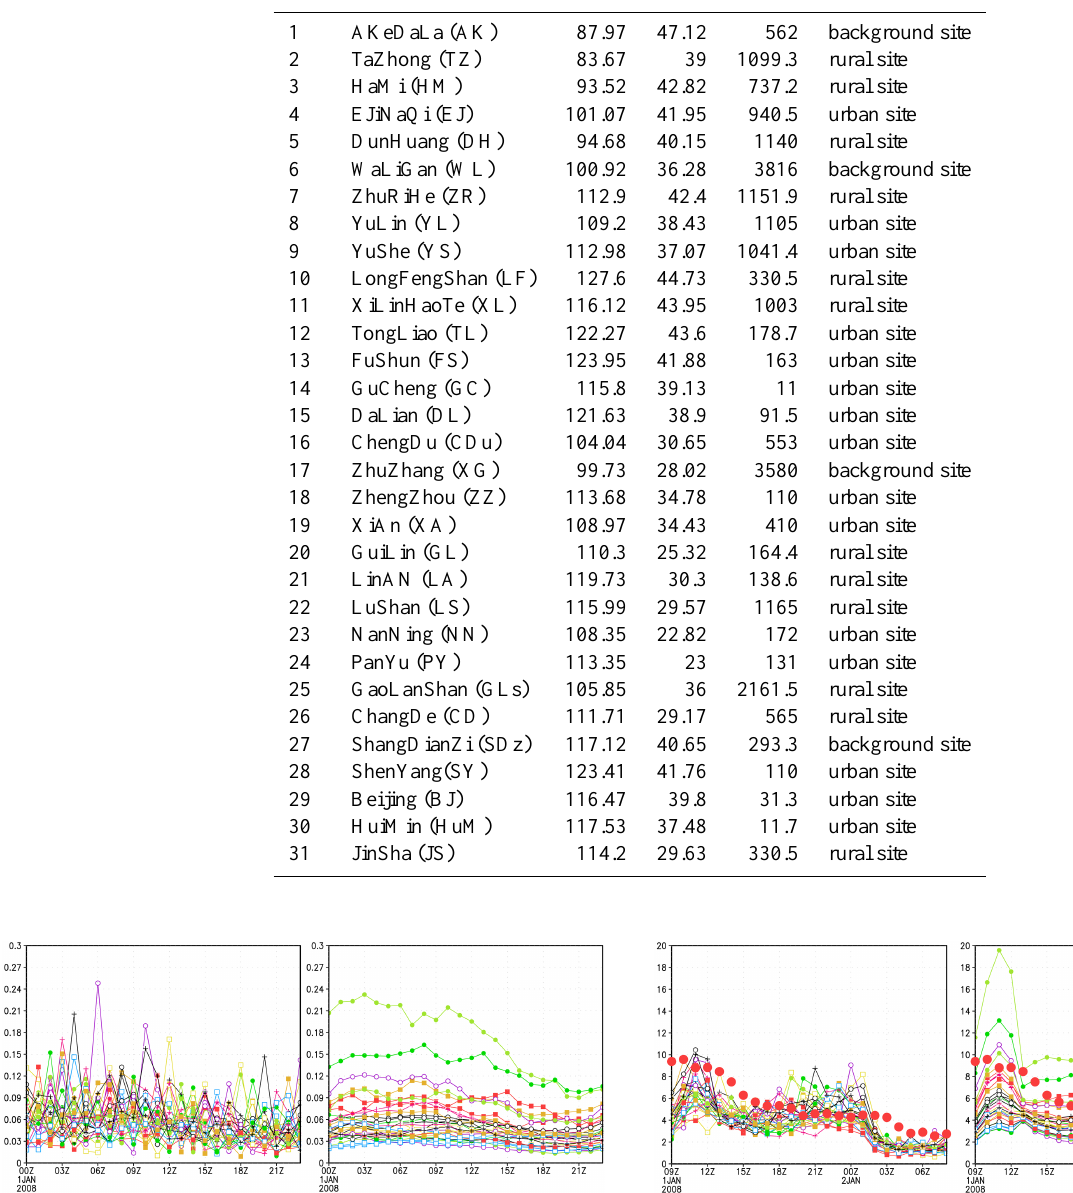
Figure 2. Emission ensembles at grid (116.5 ◦ N, 40 ◦ E): sample strategy with no time correlation (left); sample strategy with time correlation α = 0 . 9 (right) (units: mgm − 2 s − 1 ).